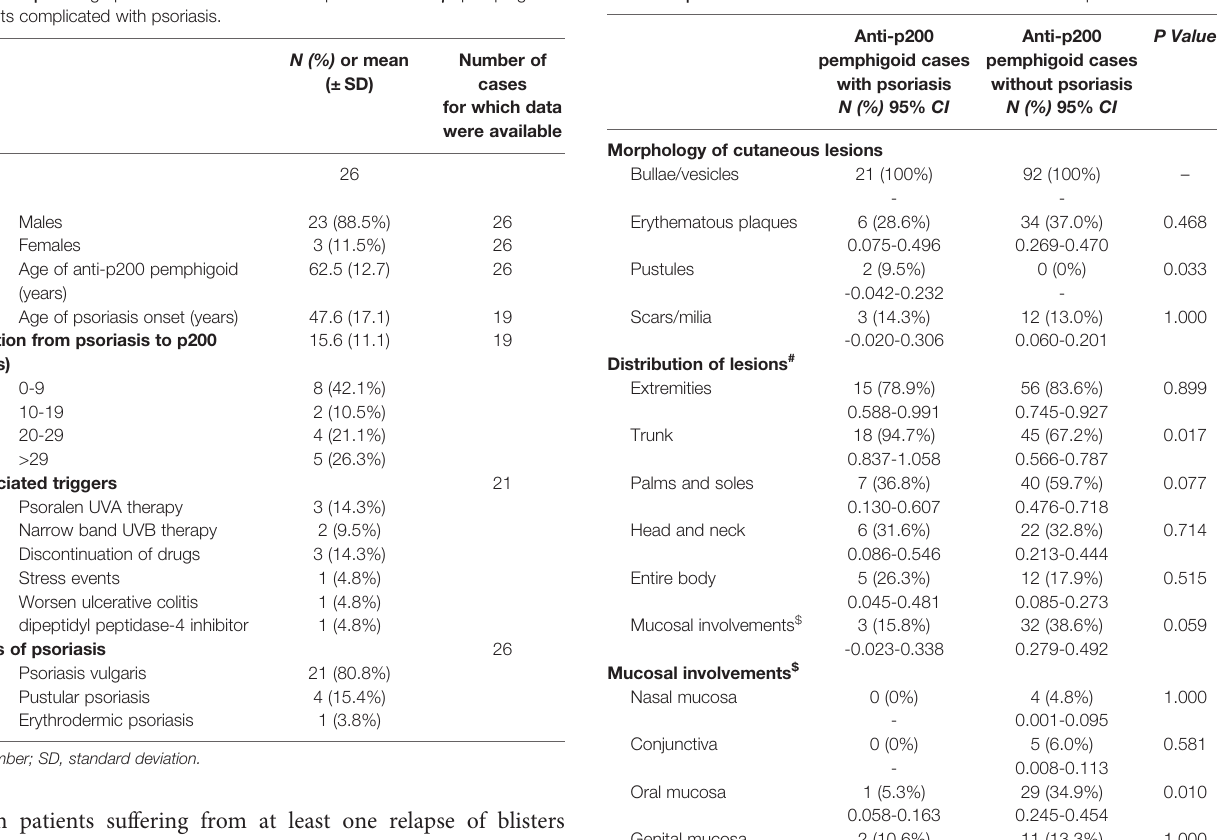
TABLE 2 | Clinical manifestation and distribution of lesions in reported